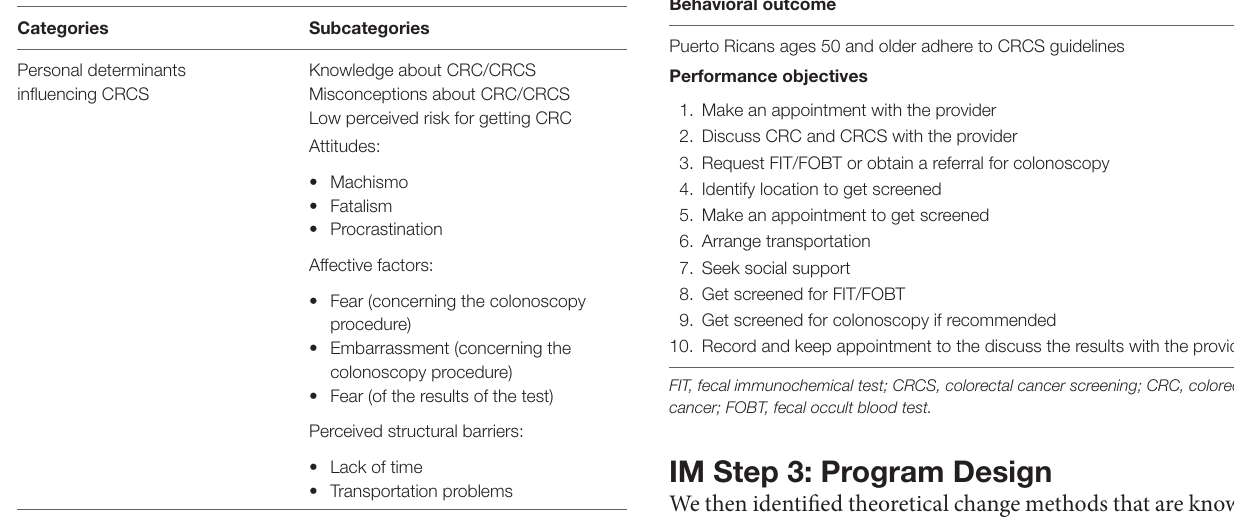
colorectal cancer screening (CRCS) among Puerto